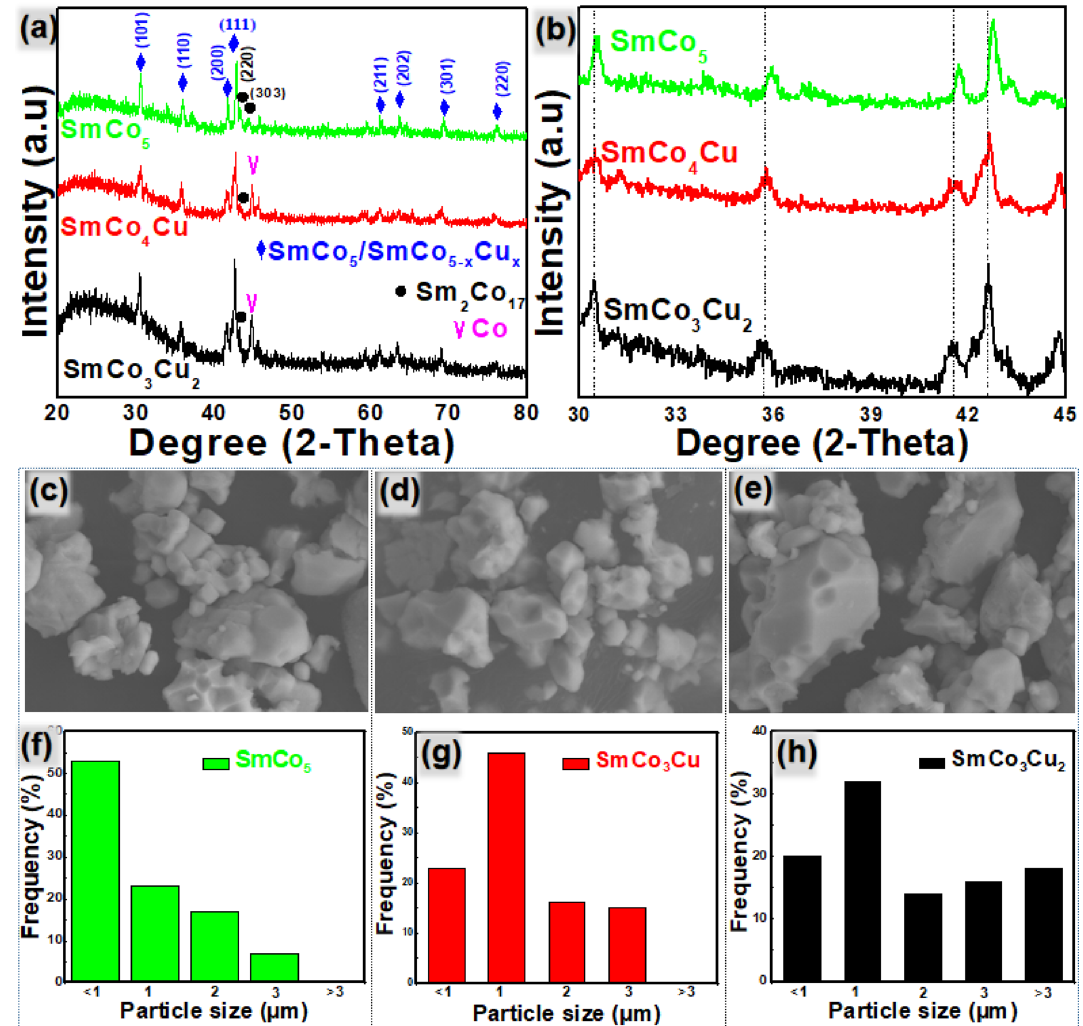
Figure 1. ( a ) XRD patterns of SmCo 5 , SmCo 4 Cu, and SmCo 3 Cu 2 . ( b ) Slight peak shift in XRD patterns of SmCo 5 , SmCo 4 Cu and SmCo 3 Cu 2. SEM images of ( c ) SmCo 5 ( d ) SmCo 4 Cu and ( e ) SmCo 3 Cu 2 . Particle size distribution of ( f ) SmCo 5 ( g ) SmCo 4 Cu and ( h ) SmCo 3 Cu 2